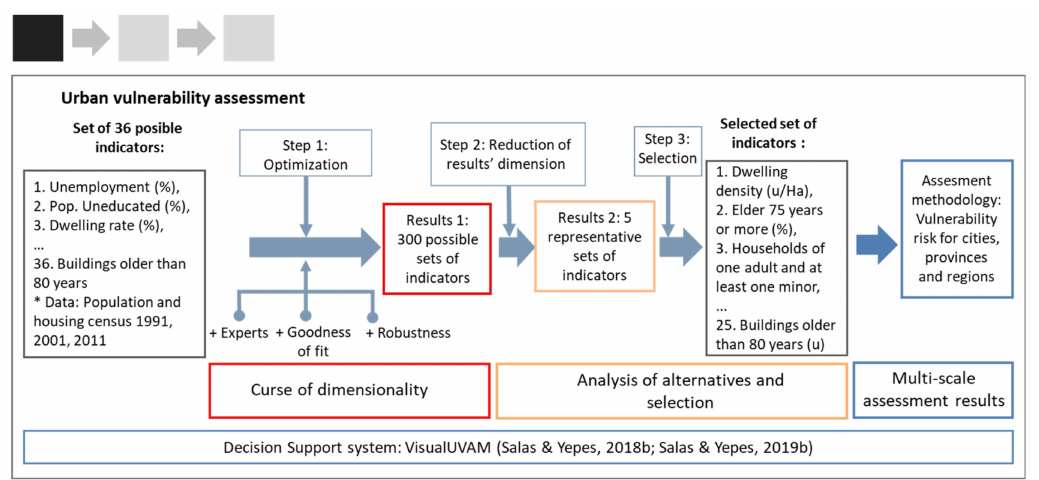
Figure 2. Step 1, urban vulnerability assessment: selection of